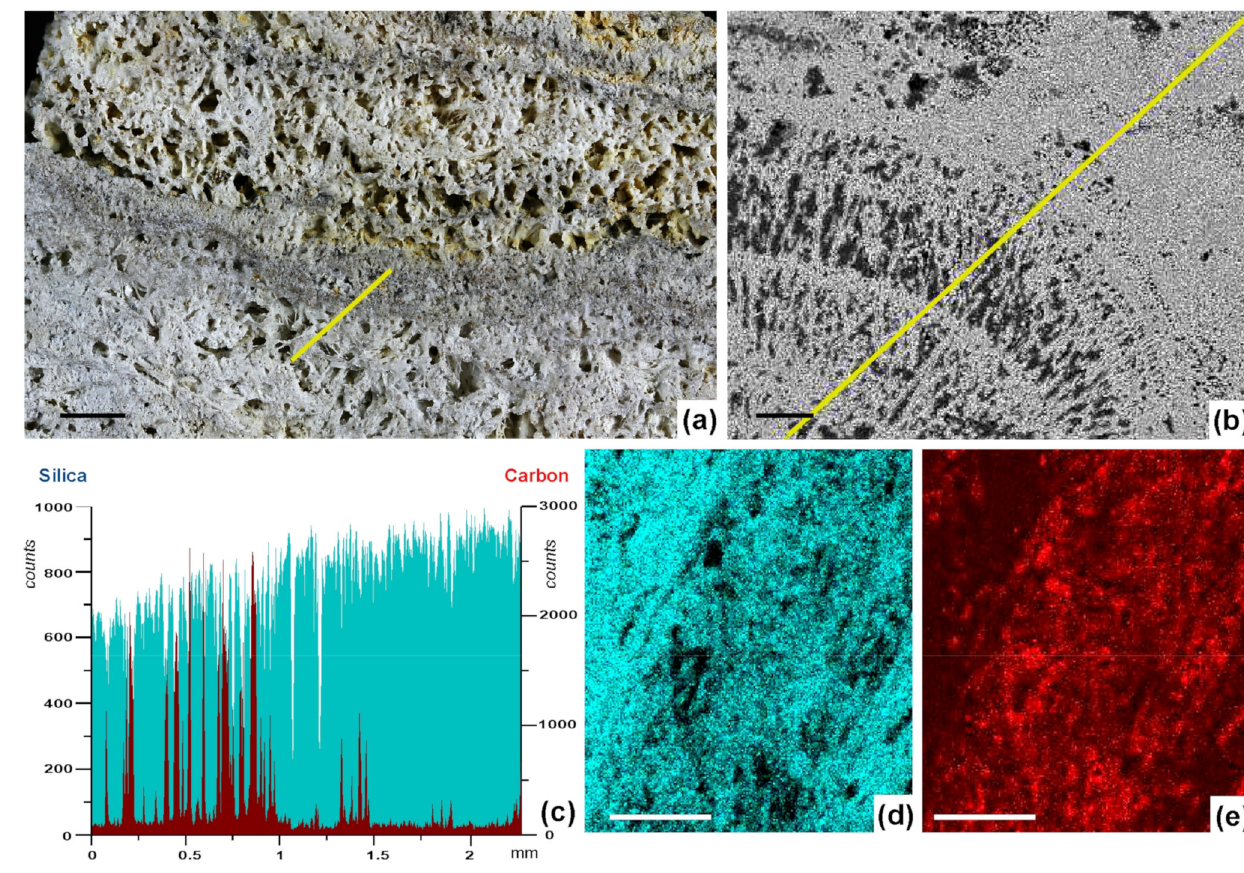
Figure 7. Modifications in the organic matter/silica ratio based on EDS and back-scattered electron image (BSE)–ESEM analyses. ( a ) Uncoated slab of laminated sample exhibiting distinct alternations of (highly porous) yellowish white and grey laminae. ( b ) Backscatter ESEM micrograph (from boxed area in previous picture) showing cross-section (yellow line) analyzed in following pictures. ( c ) Energy dispersive X-ray spectroscopy (EDS) line profiles of silica (blue) and carbon (red) showing sharp modifications in the C/Si (atomic/molar percentage) ratio, ranging from ~ 1/6 in the white to ~ 1/3 in the dark grey alternations. ( d , e ) EDS color-coded elemental maps of silica (blue) and carbon (red); elements below 5 wt% appear blurry; scale bars = 3 mm (for Figure 7a) and 1 mm (for Figure